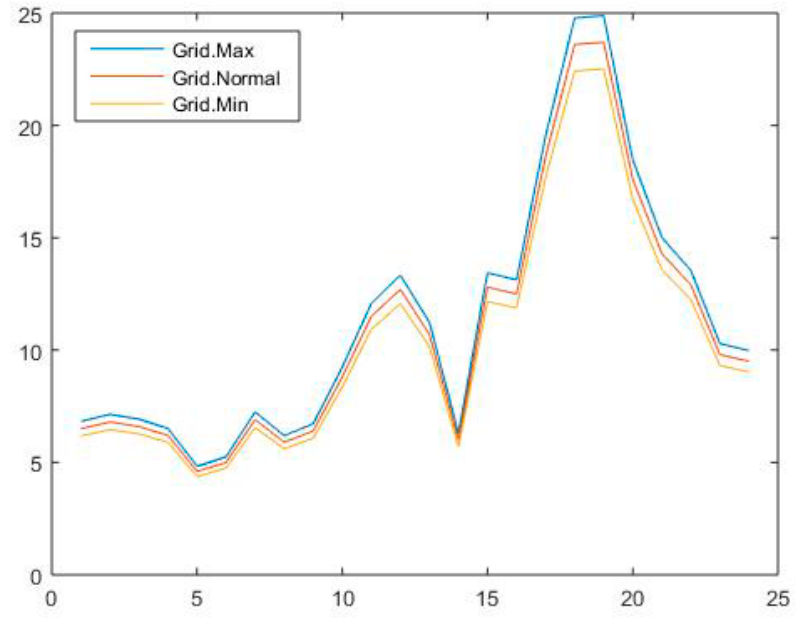
Figure 10. The result of expected input error.